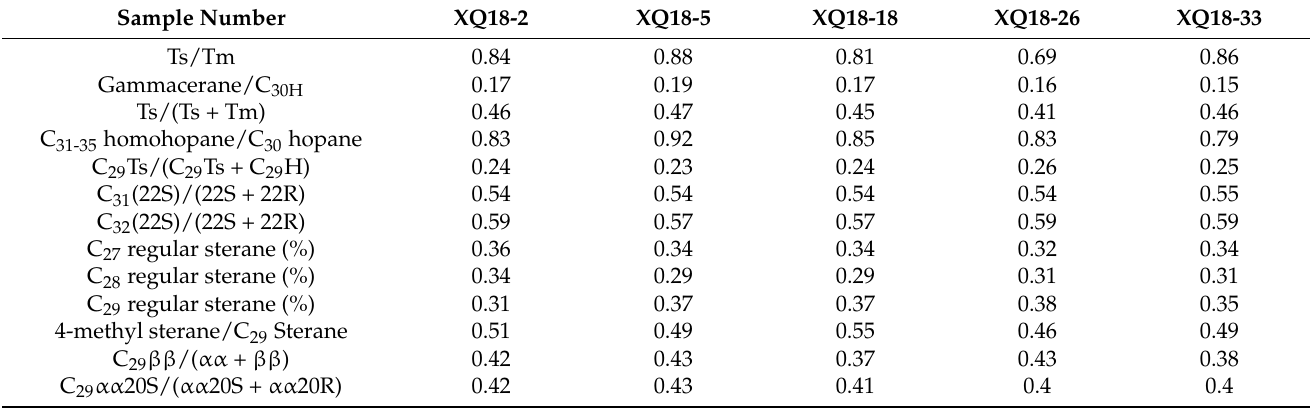
Table 2. The biomarker parameters of the reservoir bitumen in the Maidiping Member.